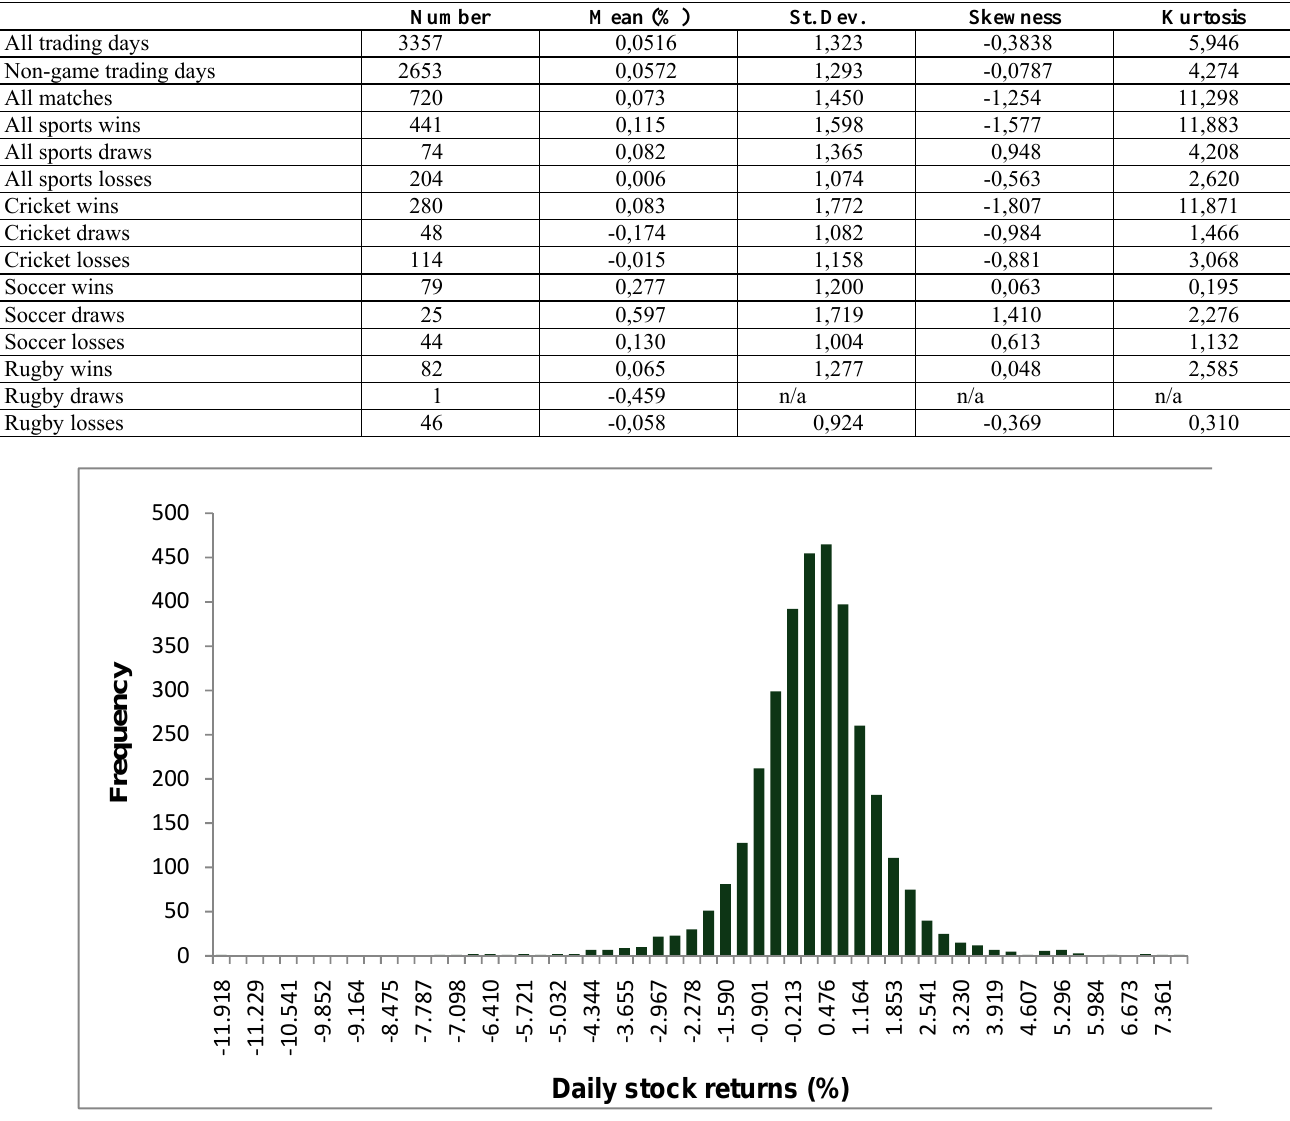
Figure 2: Data distribution of JSE All Share index daily returns for all trading